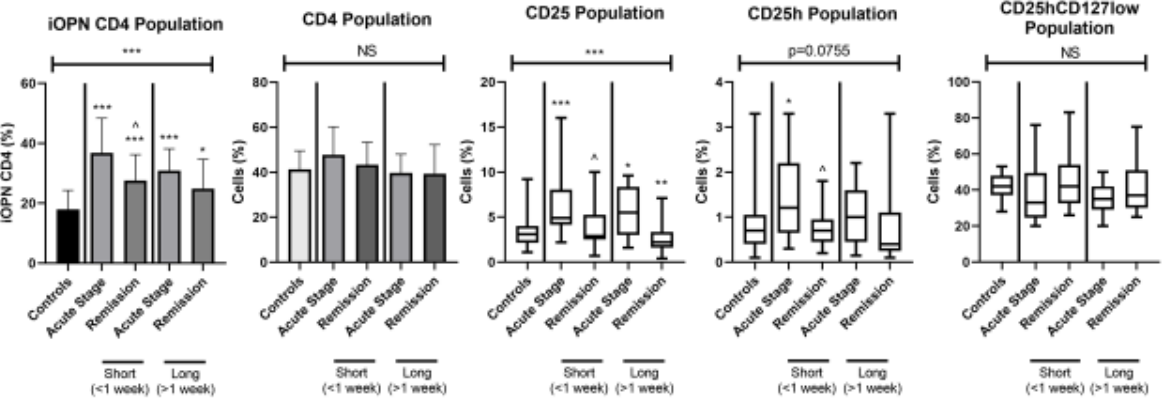
Figure 3. The examinated subpopulations of T lymphocytes in the ACD patients according to duration of skin lesions. iOPN CD4, CD4 T lymphocytes with expression of intracellular osteopontin; CD4, CD4 positive T lymphocytes; CD25, subset of CD4 positive T lymphocytes; CD25h, CD25 high T lymphocytes; CD25hCD127low, CD25highCD127low T cells—regulatory T cells; NS, non-significant; short, the duration of skin lesions <1 week; long, the duration of skin lesions >1 week; * means statistical significance with p values < 0.05 between patients with acute stage of ACD and controls; **/*** means statistical significance with p < 0.01 and 0.0001, respectively, between patients with acute stage of ACD and controls; ˆ—statistical significance with p values < 0.05 between patients with acute stage of ACD and remission.